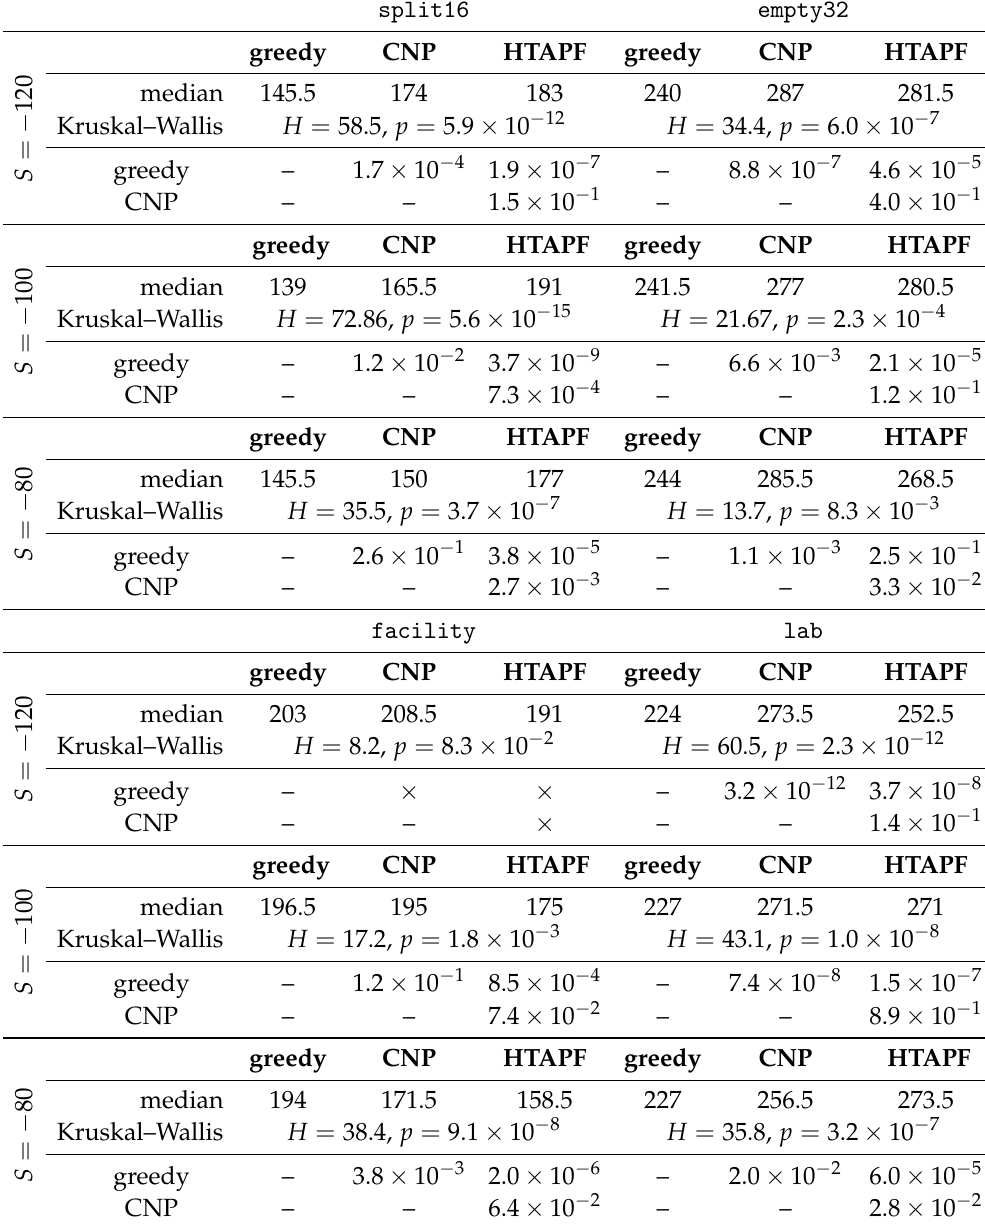
Table 2. Results of the statistical tests on the simulations performed with different limited communi- cation